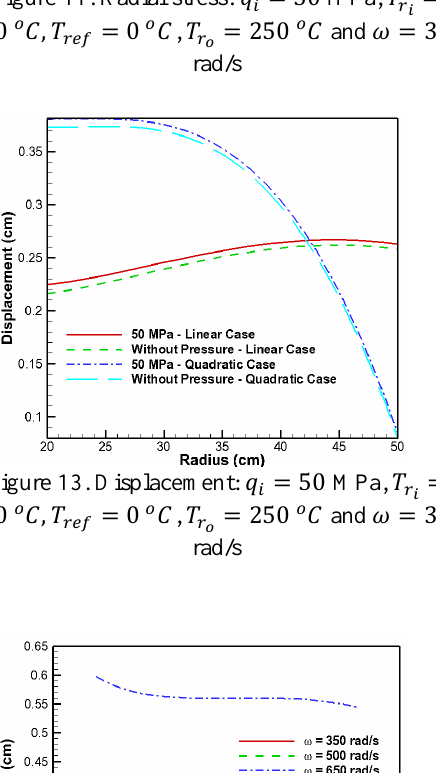
Figure 12. Tangential stress: 𝑞 = 𝑟 𝑖 500 𝑜 𝐶, 𝑇